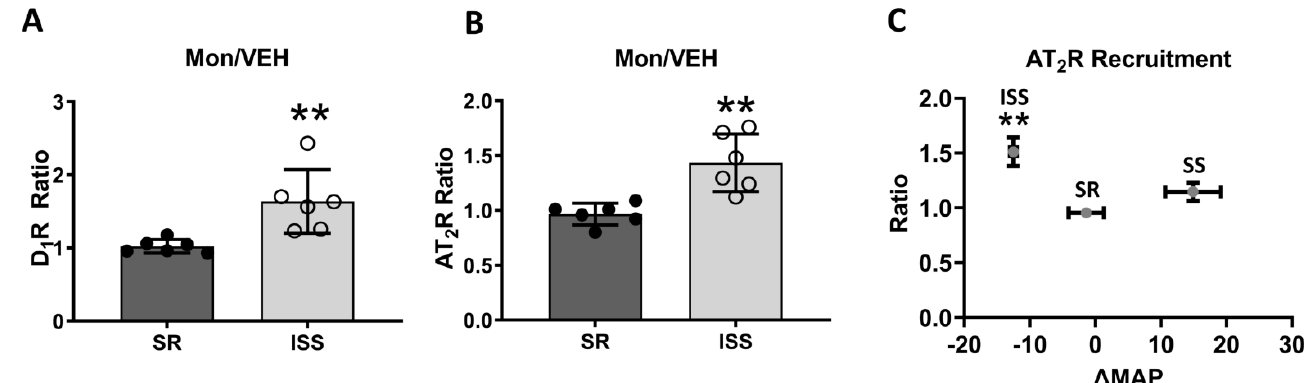
Figure 1. D 1 R and AT 2 R recruitment in urine-derived renal proximal tubule cells (uRPTCs) from salt-resistant (SR) and inverse salt-sensitive (ISS) subjects. ( A , B ) Under 1-h 10 µ M monensin (MON) treatment, there are more D 1 Rs ( A ) and AT 2 Rs ( B ) recruited to the cell membrane in ISS uRPTCs, but not in SR uRPTCs (D 1 R: MON/VEH: SR, 1.022 ± 0.038, n = 6; ISS, 1.635 ± 0.178, n = 6; t -test, ** p < 0.01; AT 2 R: MON/VEH: SR, 0.965 ± 0.04, n = 6; ISS, 1.434 ± 0.107, n = 6; t -test, ** p < 0.01). ( C ) Correlation between the degrees of salt sensitivity (SS), expressed as a change in MAP ( ∆ MAP, High Salt–Low Salt) in response to increased dietary sodium and FEN-stimulated AT 2 R membrane recruitment in directly evaluated uRPTCs. The SS index of each SS class is depicted on the X axis expressed as the mean ∆ MAP vs. AT 2 R 647/488 (representing AT 2 R recruitment from the cytosol to the plasma membrane). A higher ratio of FEN-induced plasma membrane AT 2 R expression is observed in ISS individuals compared with SR individuals (AT 2 R: FEN/VEH: ISS, 1.51 ± 0.13, n = 4, mean ∆ MAP = − 12.5 mm Hg; SR, 0.955 ± 0.04, n = 4, mean ∆ MAP = − 1.38; SS, 1.148 ± 0.082, n = 3, mean ∆ MAP = +14.9 mm Hg; one-way ANOVA, Holm-Sidak post hoc test ** p <